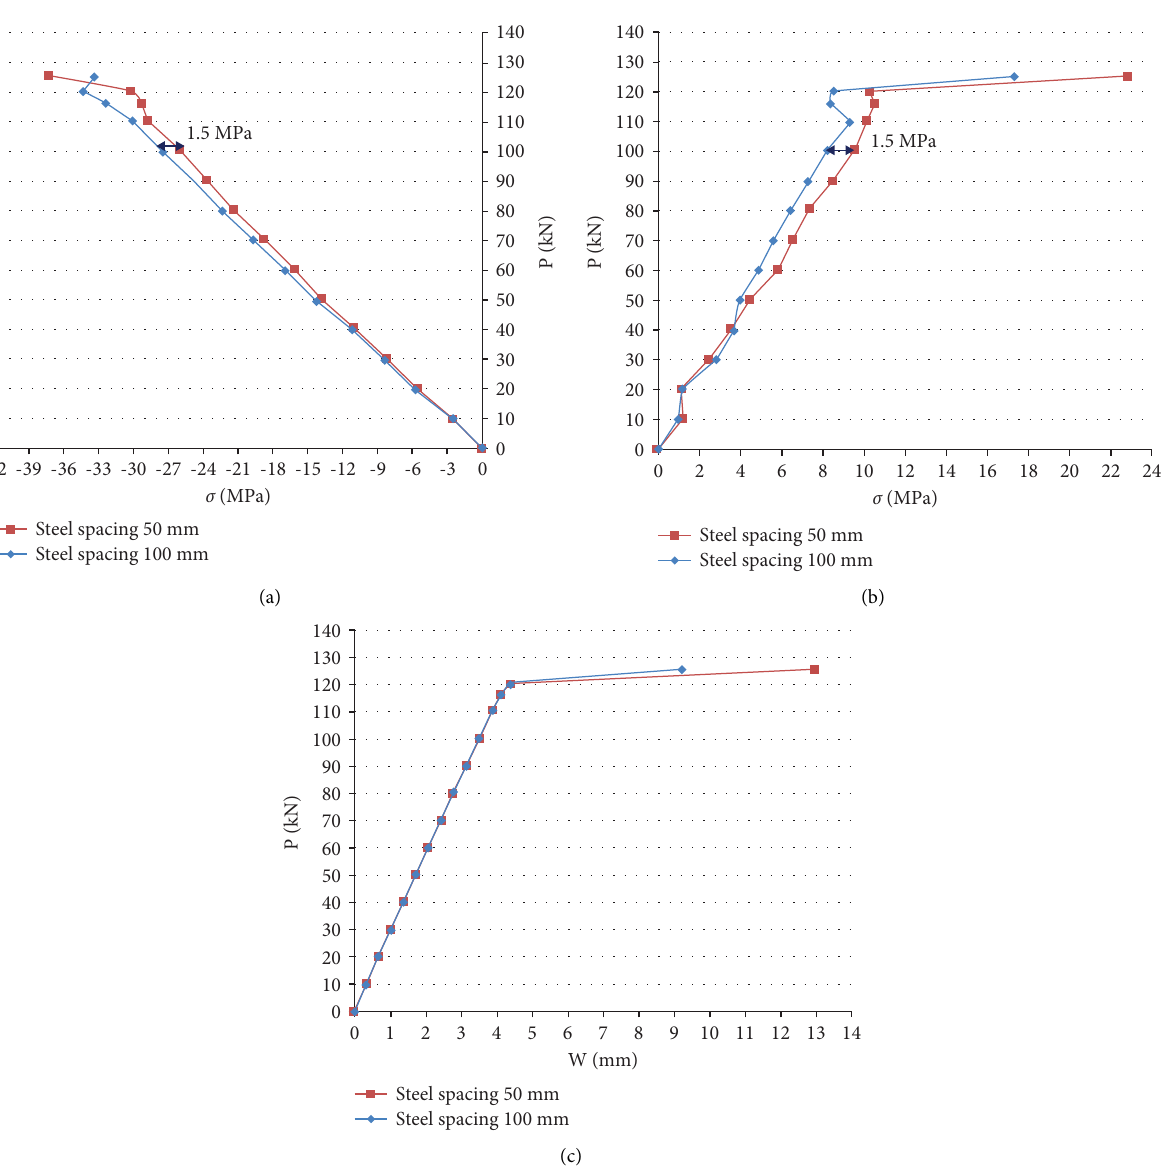
Figure 15: Relationship between load and stress, as well as between load and vertical displacement (efect of stirrups): (a) relationship between load and compressive stress, (b) relationship between load and tensile stress. (c) the relationship between load and